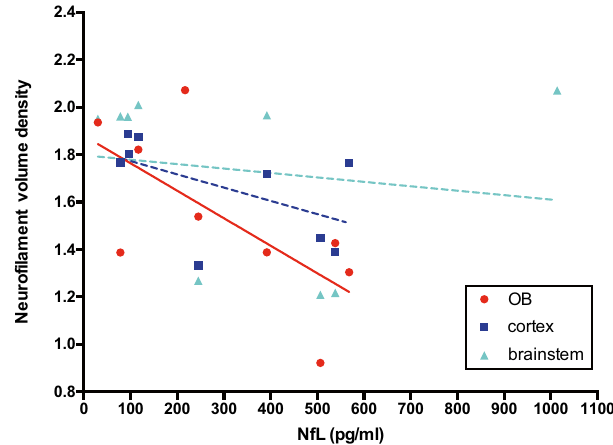
Figure 3. Neurofilament density volume in the olfactory bulb negatively correlates with serum neurofilament light chain (NfL) levels in contrast to the other regions. This suggests that changes in NfL serum levels in experimental cerebral malaria (ECM) are mainly driven by the location of brain injury and reflect less brain injuries as a sum. (n healthy control = 3 per region, n reversible edema = 3 per region, n irreversible edema = 3 per